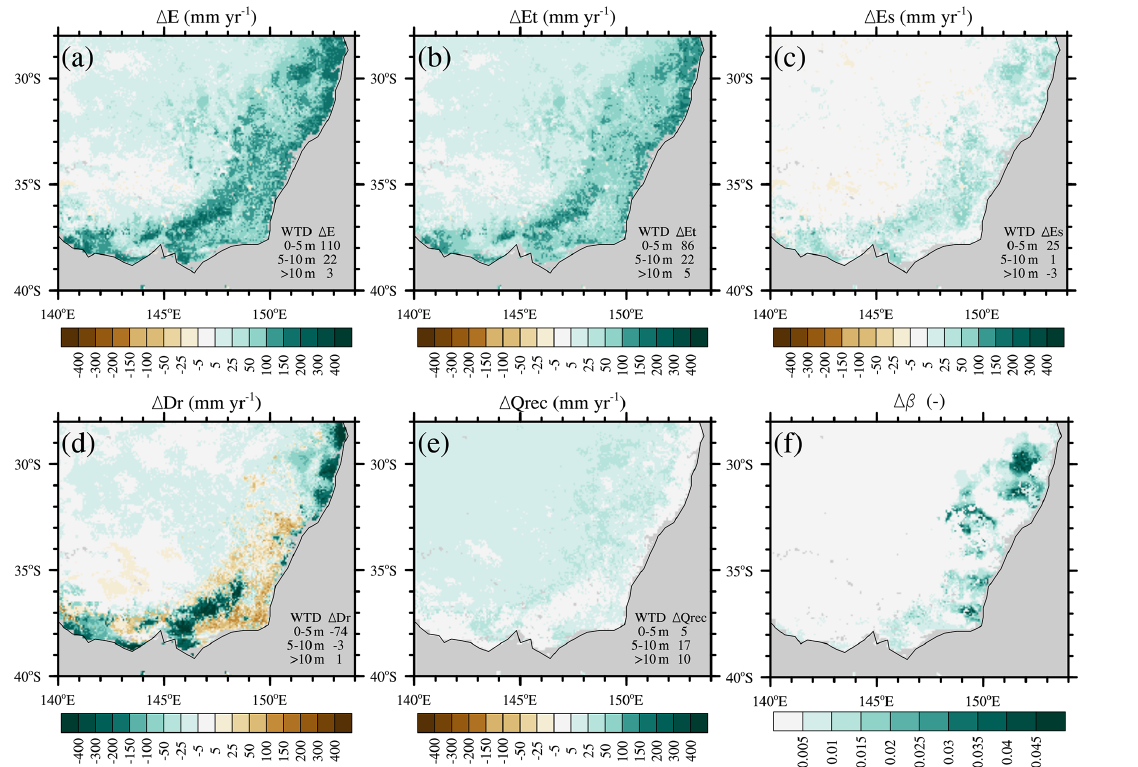
Figure 2. The overall influence of groundwater during the recent drought. Panels (a) – (e) are the difference (GW–FD) in evapotranspiration ( (cid:49)E ), transpiration ( (cid:49)E t ), soil evaporation ( (cid:49)E s ), vertical drainage ( (cid:49)D r ) and recharge from the aquifer to soil column ( (cid:49)Q rec ), respec- tively. In the bottom right of panels (a) – (e) , the average of each variable over selected water table depths (WTDs) is provided. Panel (f) is the maximum nighttime water stress factor difference ( (cid:49)β ) between 03:00 (i.e. predawn when the soil is relatively moist following capillary lift overnight) and 21:00 the previous day. We only include rainless nights in January 2019 to calculate (cid:49)β to remove any influence of overnight